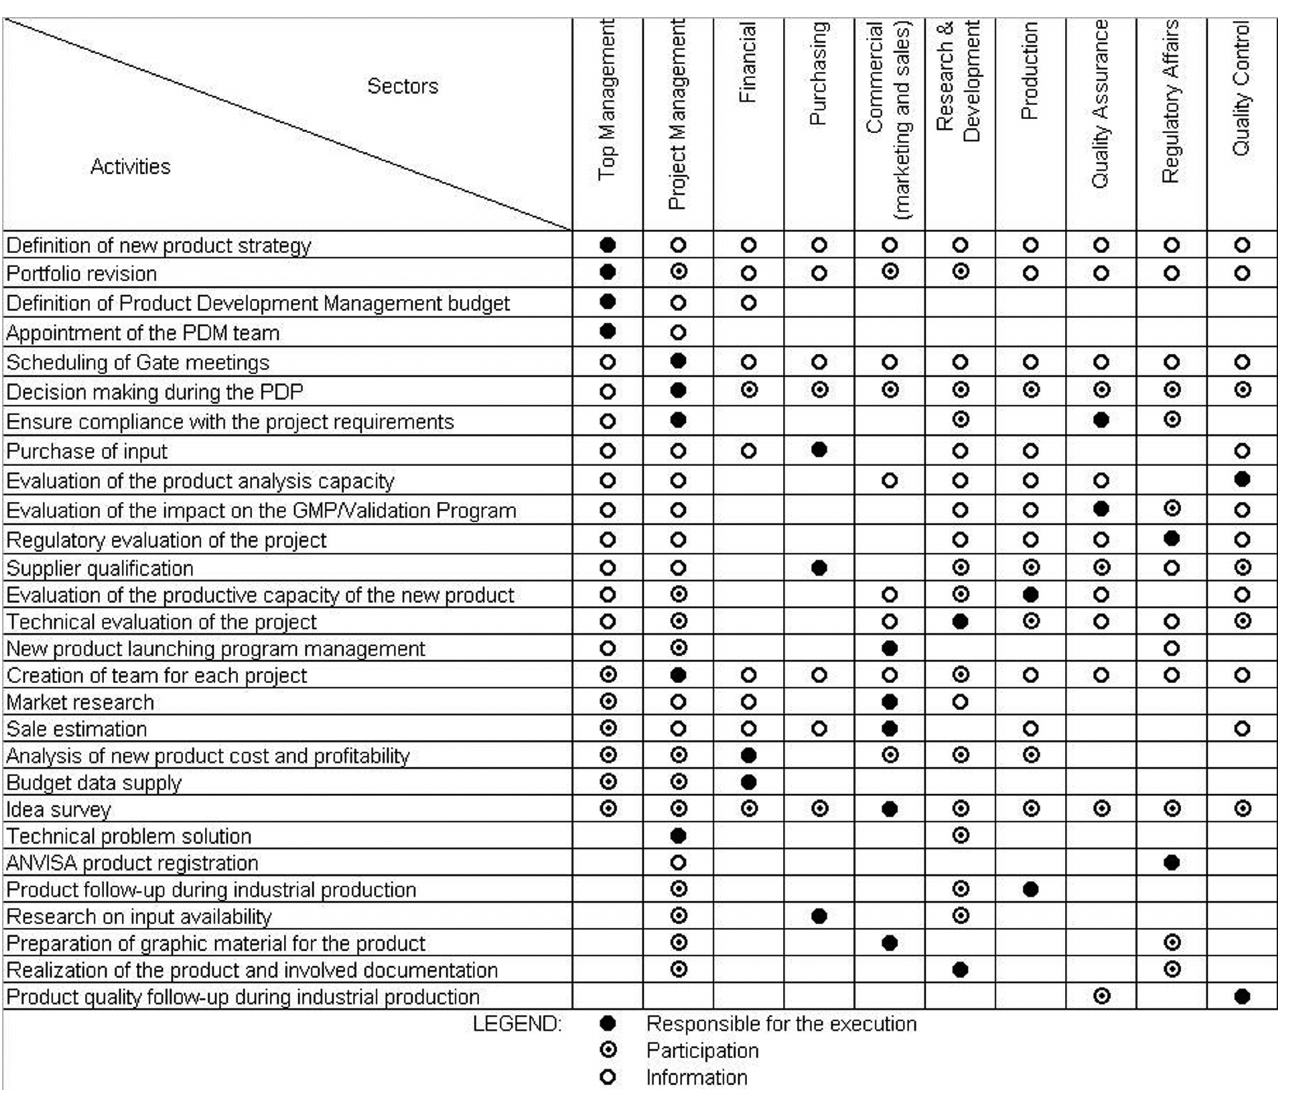
FIGURE 6 – Responsibility matrix of PDM team